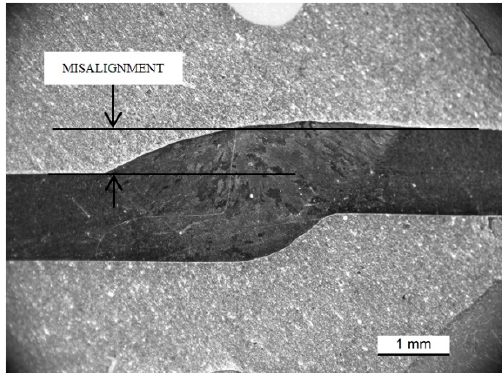
Figure 2. A case of severe misalignment; such welds were not assessed in this study. Welding parameters used for this weld: I p = 110 A; TS = 3 mm/s; f = 1.5 Hz; R = 400 mm/min; D = 1 mm; N = 0%.